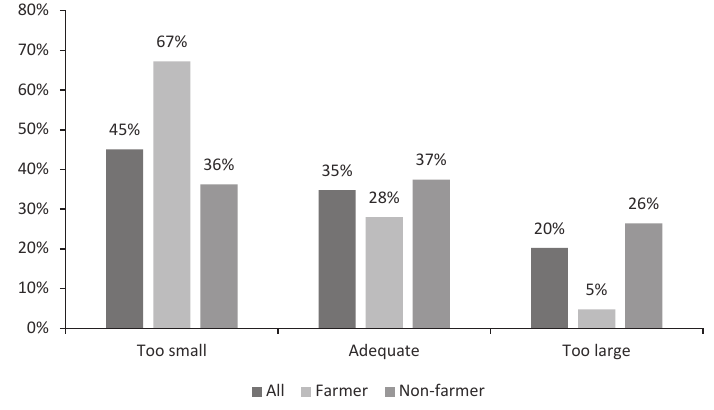
Fig. 2. Budget size evaluations by farmers, non-farmers and all